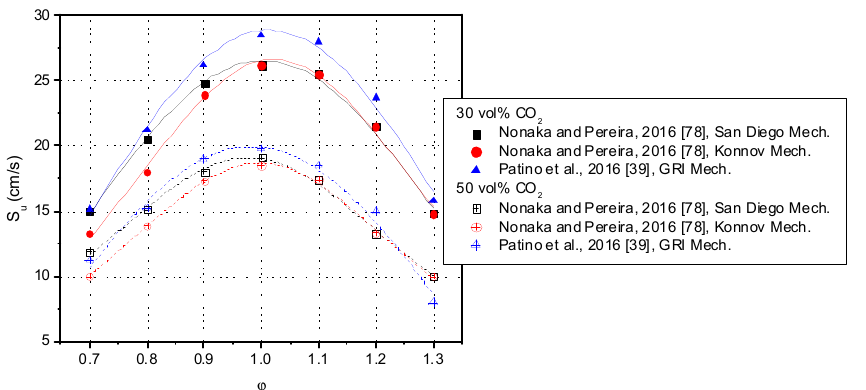
Figure 4. Variation of the calculated laminar burning velocities of biogas-air mixtures with various equivalence ratios, at different CO 2 contents and standard initial conditions.